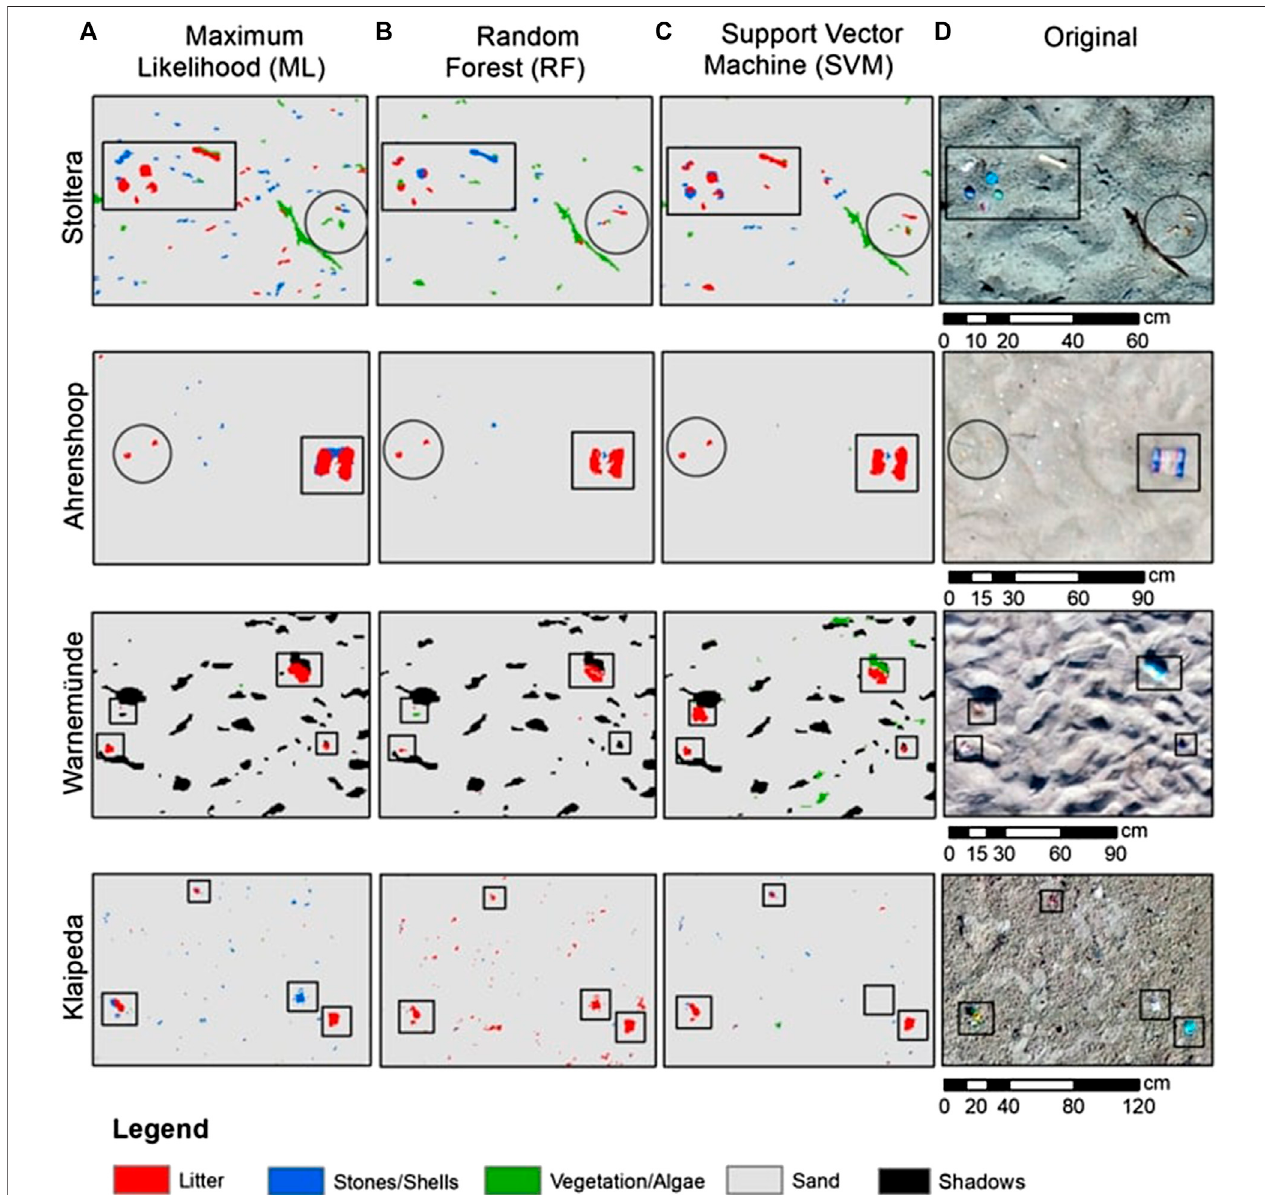
FIGURE 4 | Comparison of supervised classi fi cation with four classes with the algorithms ML, RF, and SVM on erial images at 10 m for the site Stoltera, Ahrenshoop, Warnemünde and Klaipeda. Each close-up image shows litter objects on the recovery site (D) and their classi fi cation result (A – C) , such as litter objects of different sizes (square) and cigarette butts (1 – 2.5 cm)